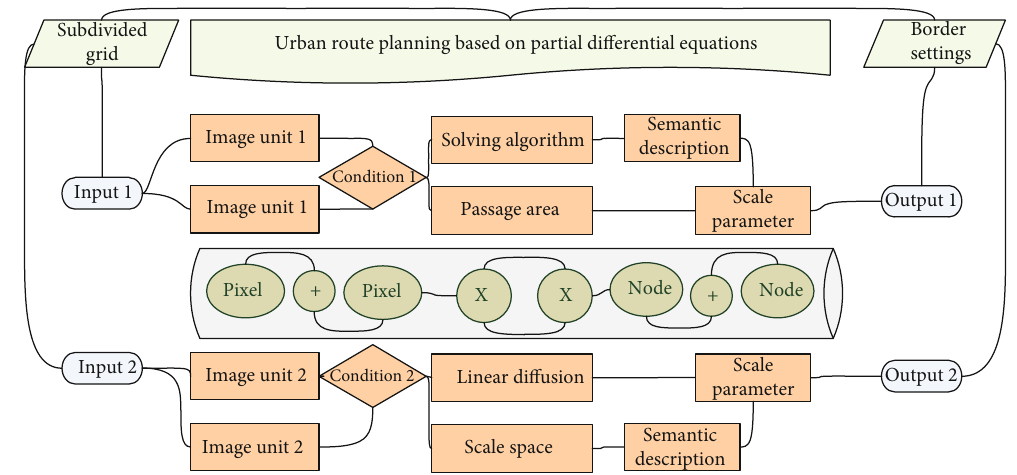
Figure 2: Flow chart of image feature enhancement